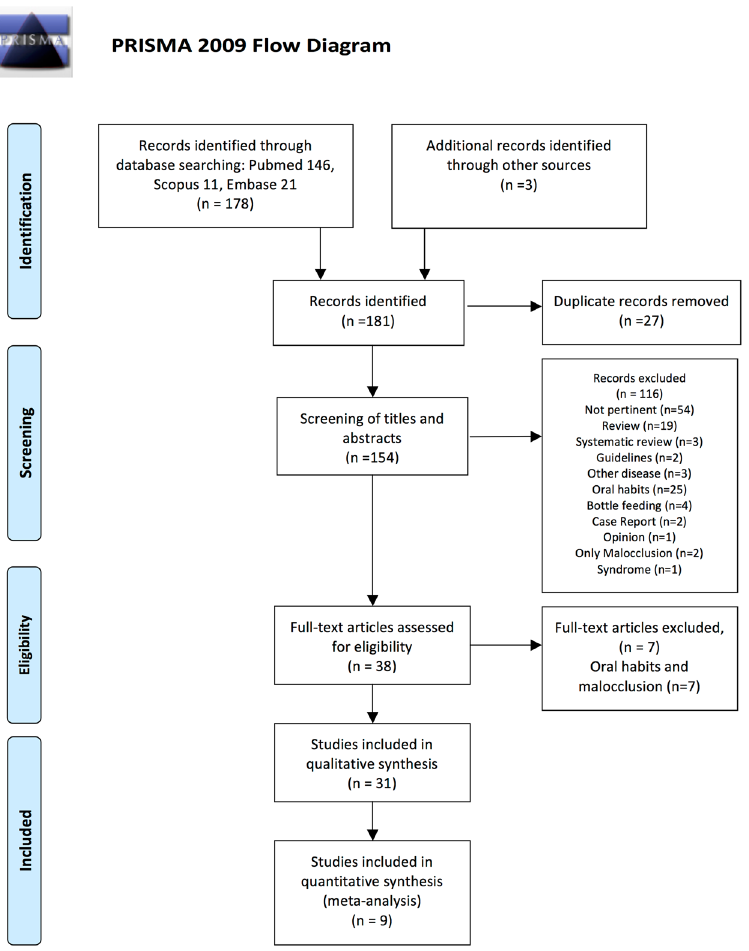
Figure 1. PRISMA 2009 Flow Diagram. From: Moher D, Liberati A, Tetzlaff J, Altman DG, The PRISMA Group (2009). Preferred Reporting Items for Systematic Reviews and Meta-Analyses: The PRISMA Statement. PLoS Med 6(7): e1000097.